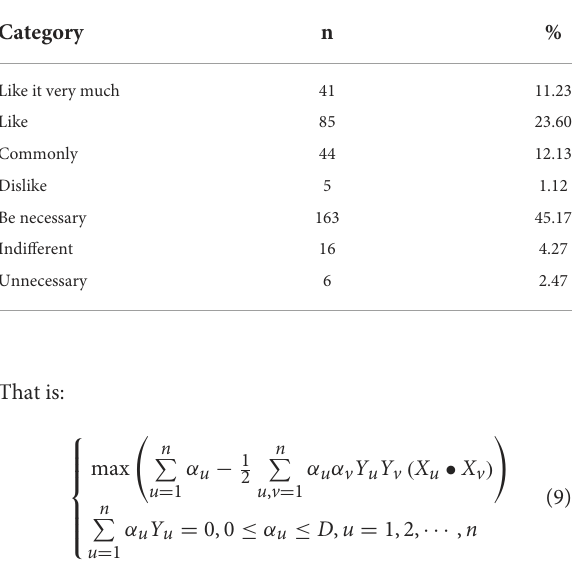
TABLE 2 Statistics list of physical exercise items selected by disabled